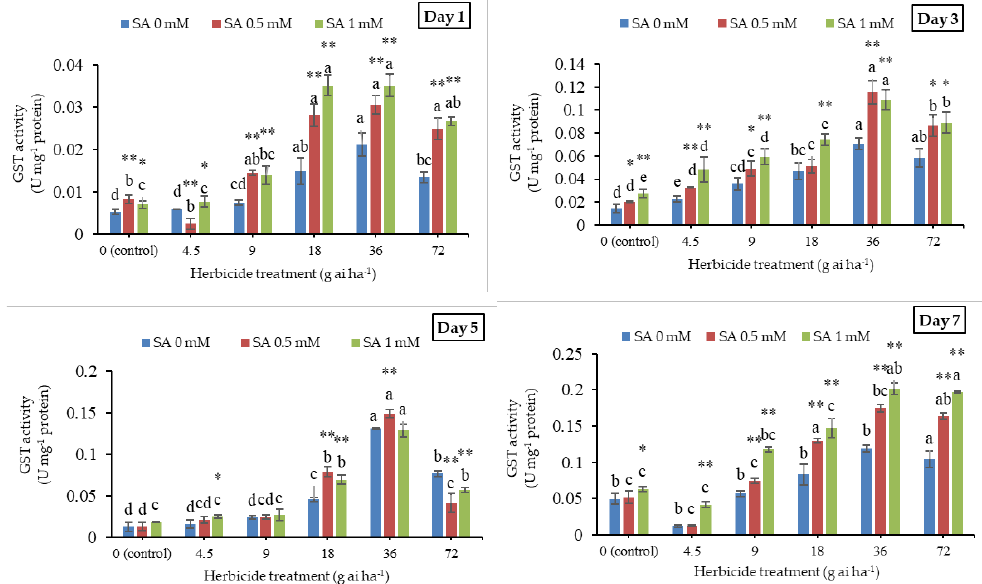
Figure 7. Changes in glutathione S-transferase (GST) activity in the leaf tissues of wheat at 1, 3, 5, and 7 days after herbicide application at different rates. The leaves were pre-treated with different concentration of salicylic acid (SA) 3 days prior to herbicide application. The bars represent the treatment mean ± SD ( n = 4), and the bars with different lower-case letters were significantly ( p ≤ 0.05) different, according to the Duncan ’ s test. Asterisks indicate significant difference between the herbicide only and herbicide with each concentration of SA, according to the Independent Samples t -test.